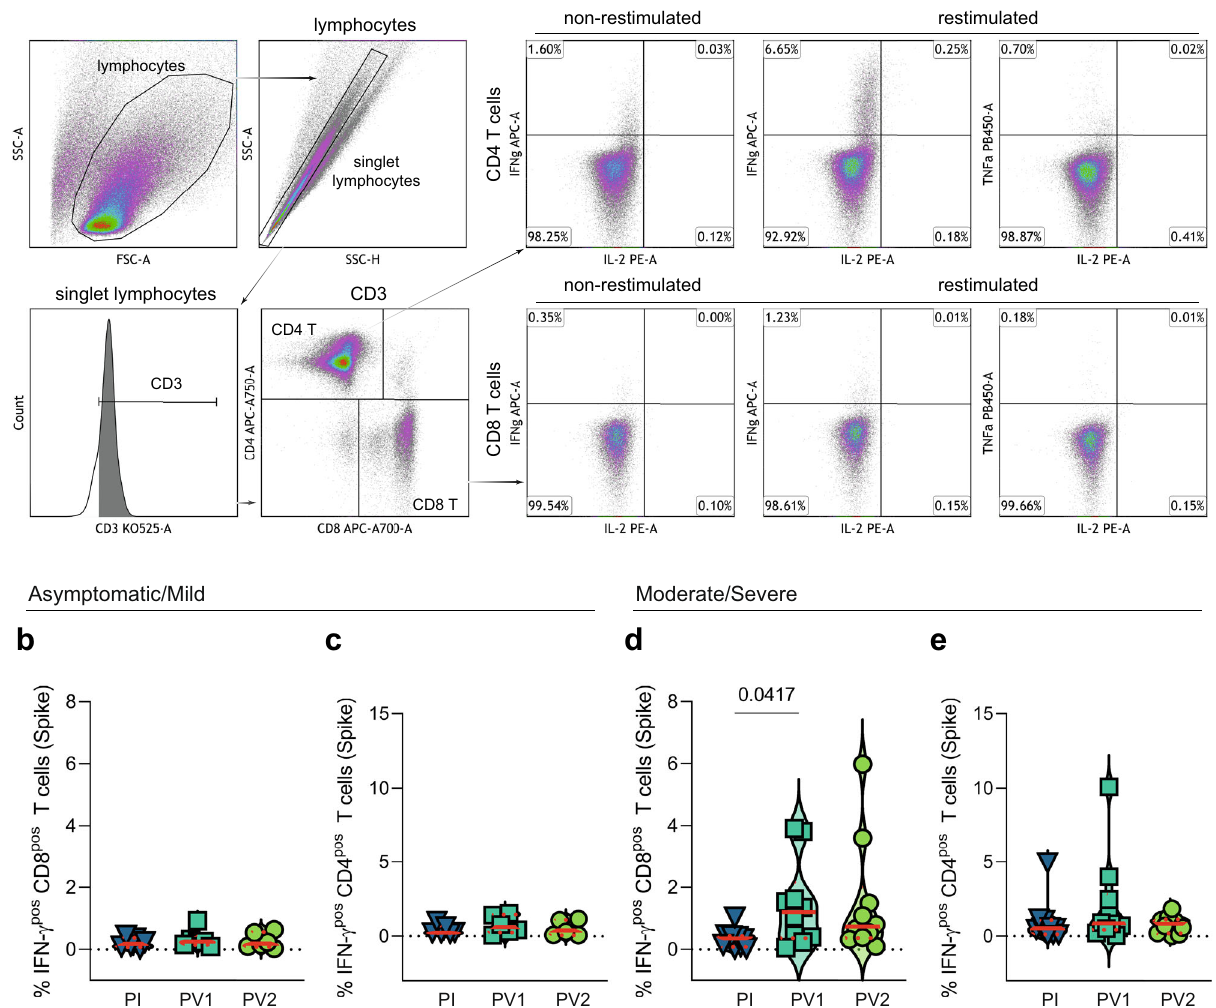
Fig. 6 Effector CD4 + and CD8 + T-cell responses to SARS-CoV-2 S peptides following 7 day in vitro stimulation. a Lymphocytes were identi fi ed by scatter characteristics and doublet exclusion (singlet lymphocytes) then T cells identi fi ed as CD3 + lymphocytes and subsets distinguished by either CD4 or CD8 expression. Bivariate analysis identi fi ed subsets of CD4 + T cells (top panel) and CD8 + T cells (bottom panel) producing TNF- α , IFN- γ and IL-2 after restimulation at day 7 and background signals from non-restimulated cells were subtracted. Percentages of IFN- γ + CD8 + and CD4 + T cells are shown for sequential samples obtained after infection, PV1 and PV2 for b , c asymptomatic/ mild ( n = 6) and d , e moderate/severe ( n = 11) groups. P values, calculated using Friedman ’ s test with Dunn ’ s multiple comparisons test, are shown above lines spanning the comparison groups when signi fi cant. Red lines bisecting groups represent median (solid) with IQR